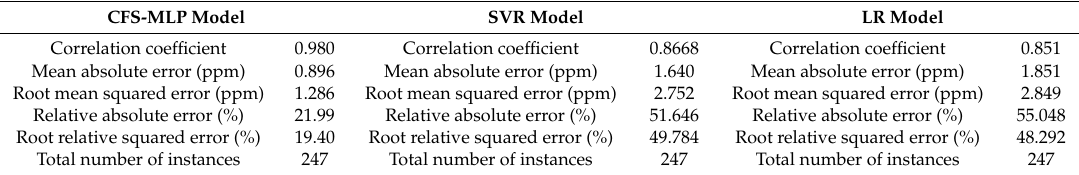
Table 7. The comparison between CFS-MLP, SVR and LR